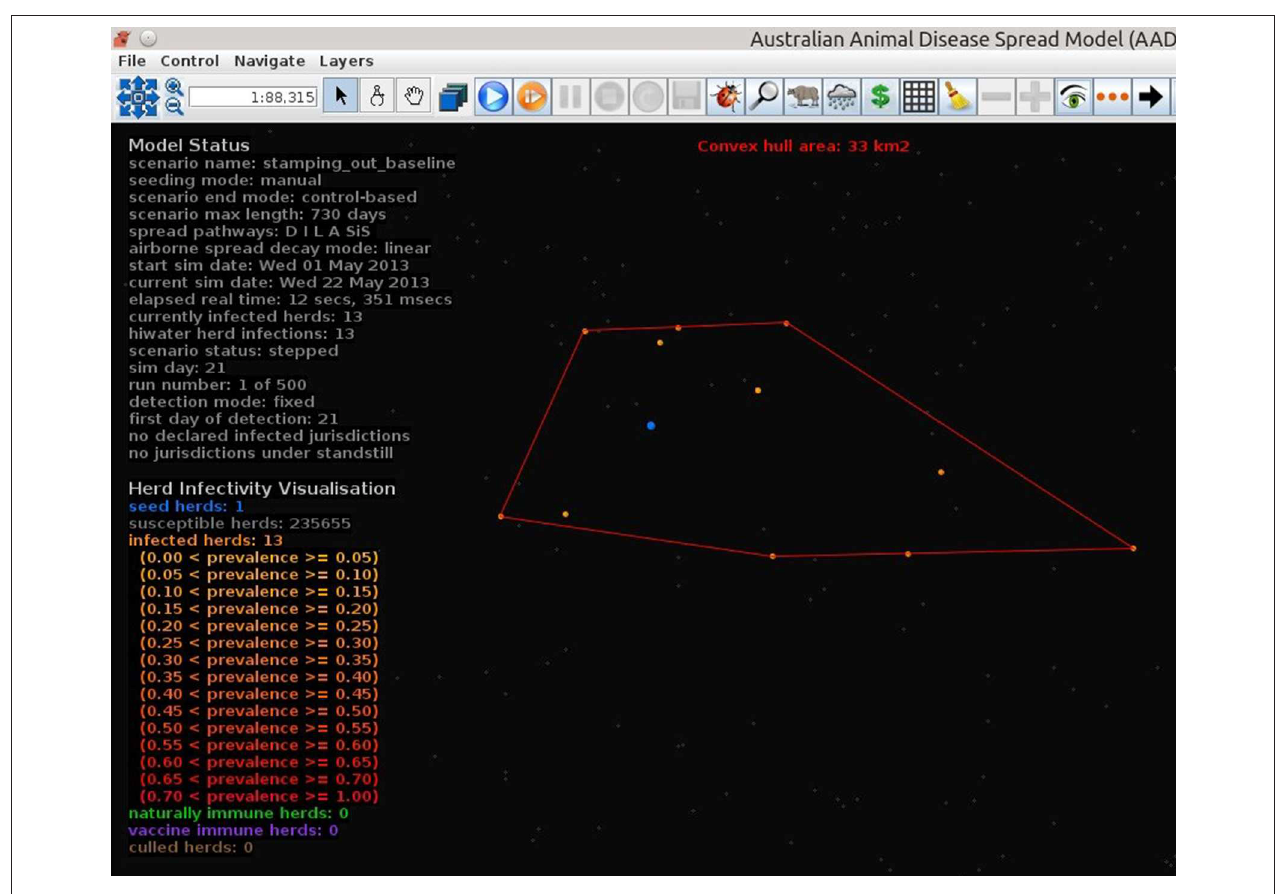
FIGURE 7 | Visualization of within-herd prevalence as